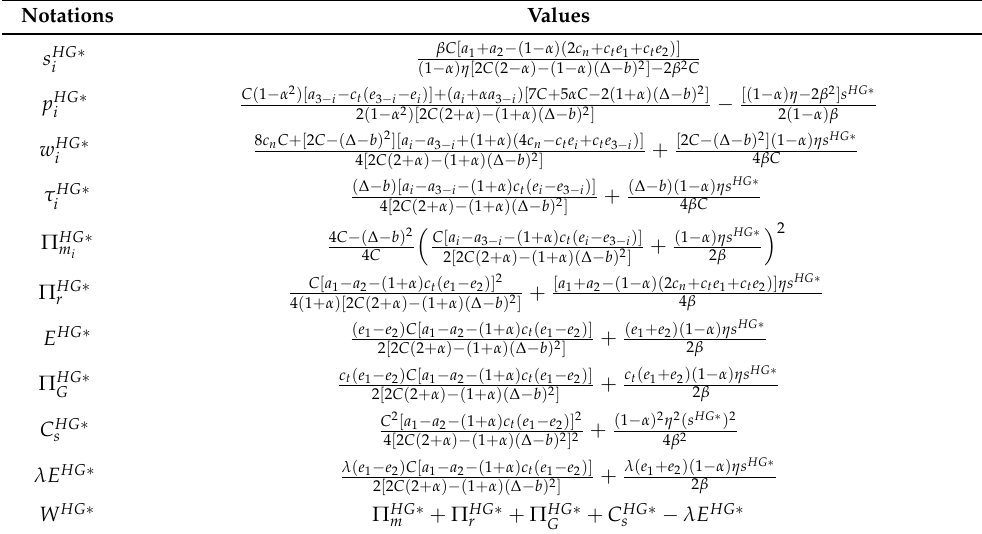
Table 4. Main results for the decentralized model of retailer with green marketing, i = 1, 2.